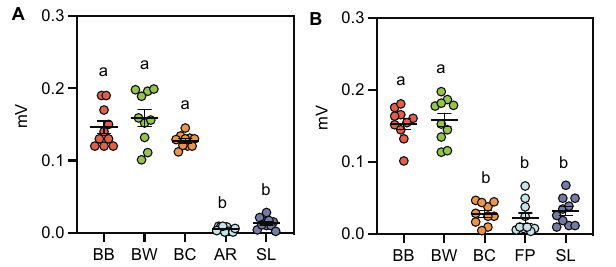
Figure 2. Electroantennogram (EAG) and Electrotarsogram (ETG) of chemical cues from beehives . Wax moths’ antenna and tarsus were subjected to electrophysiological study. ( A ) We found that the olfactory system (represented by antenna) responded significantly to chemical cues from beehive with bees (BB), beehive without bees (BW) and beehive with conspecifics (BC). ( B ) However, the contact-chemoreception system (represented by tarsi) responded significantly to chemical cues from beehive with bees (BB) and beehive without bees (BW). Air (AR), filter paper (FP) and solvent (SL) were used as control. Error bars represent s.e.m. Date were analyzed using One-way ANOVA. Similar letters indicate the absence of significant differences.